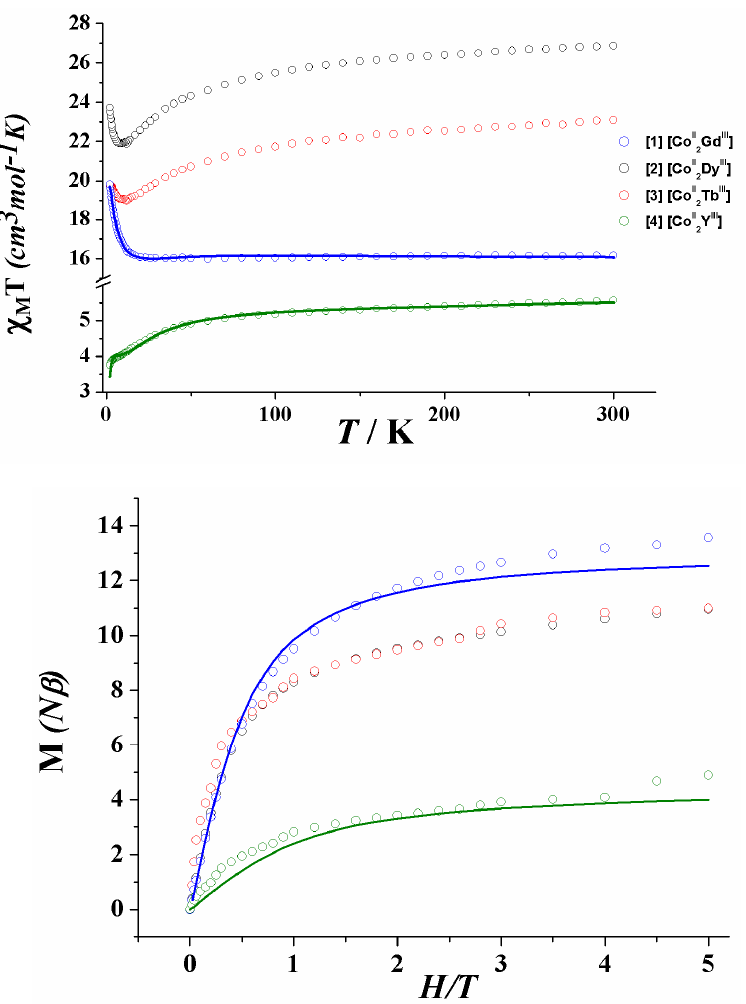
Figure 2. χ M T vs. T plots ( top ) and field dependence of the magnetization at 2 K ( bottom ) for 1–4 . Solid line represents the best fit for 1 and 4 .